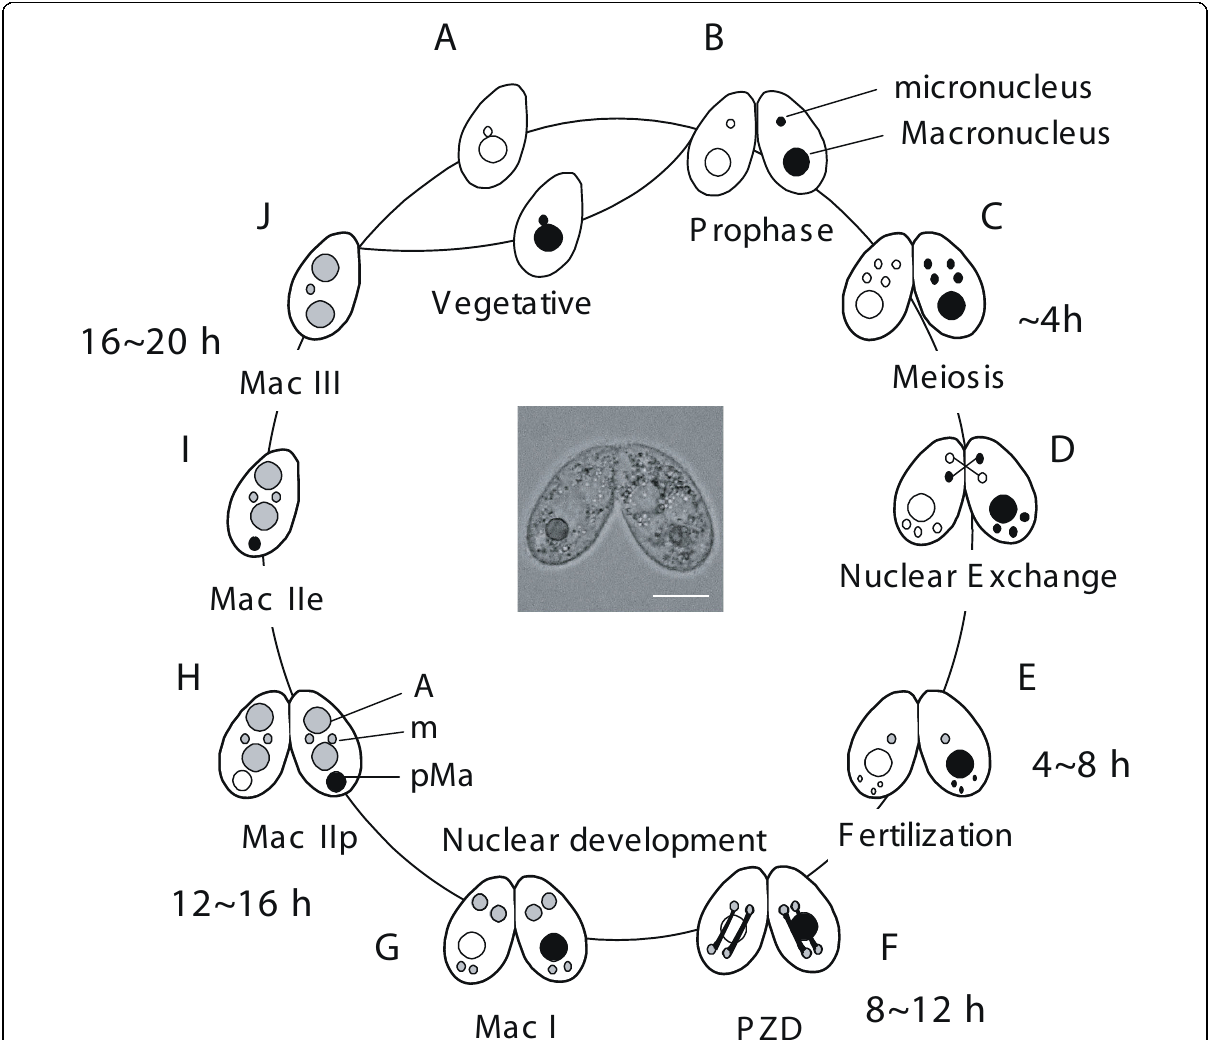
Figure 1 Nuclear events during conjugation of Tetrahymena thermophila . Conjugation in T. thermophila is a complicated process that is initiated by interaction between complementary mating types, which form a conjugating pair. A. Vegetative phase. B. Meiotic prophase. C. Meiosis. D. Nuclear exchange. One of four meiotic products mitotically divides, forming two pronucei. Subsequently, one of the pronuclei is reciprocally exchanged between mating partners. E. Fertilization (synkaryon formation). F. PZD (postzygotic division). Fertilized nucleus successively divides twice. G. Mac I. Anteriorly-located nuclei differentiate into the new macronuclei, while posterior nuclei remain the micronuclei. H. Mac IIp. The parental macronucleus migrates posteriorly and begins to degenerate. I. Mac IIe. Pair separates (exconjugants). J. Mac III. One of two micronuclei is eliminated. Progeny of T. thermophila do not undergo conjugation during the first ~100 vegetative fissions after conjugation called “ immature. ” A: macronuclear anlagen. m: micronuclei. pMa: parental macronucleus. The scale bar in photograph indicates 10 μ